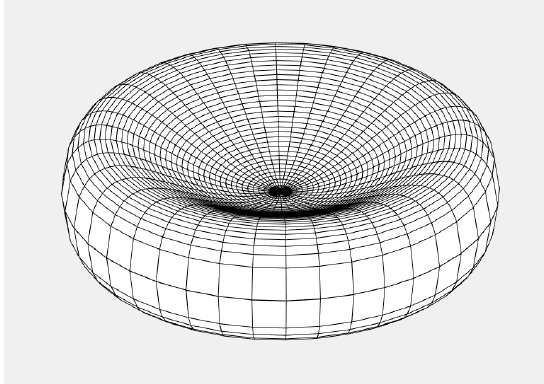
Figure 4. Average intensity of the Poynting vector, the vector is proportional to ( E × B )( ω )